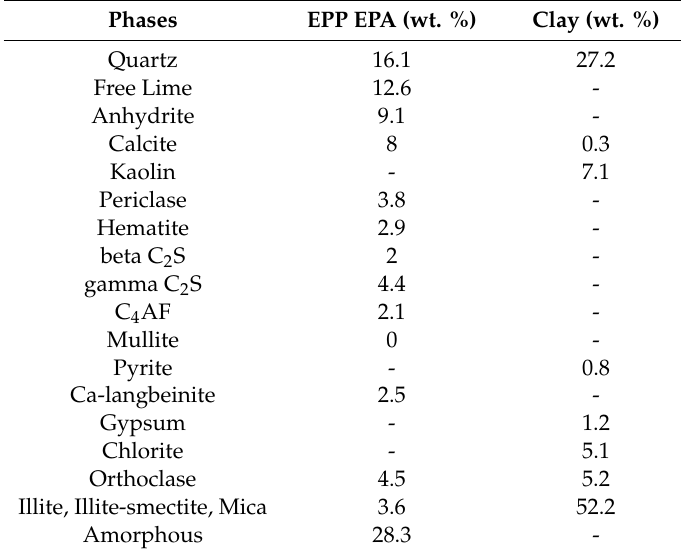
Table 5. Phase composition of EPP-EPA and clay.